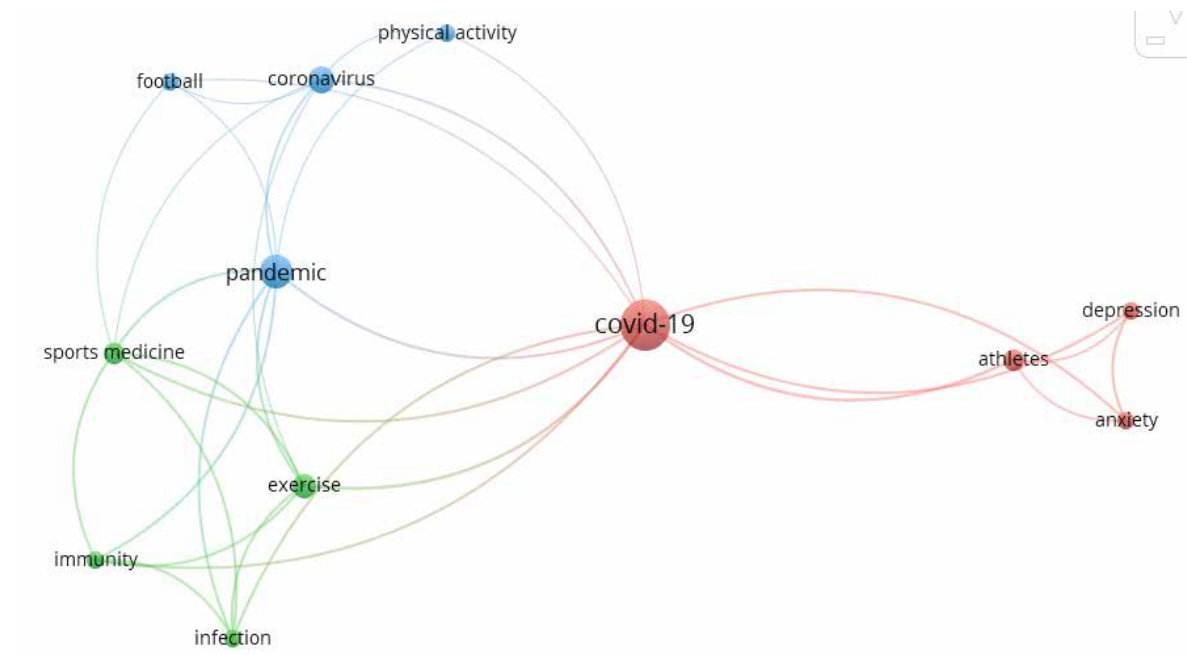
Figure 5. Network mapping on the key-word co-occurrence of these